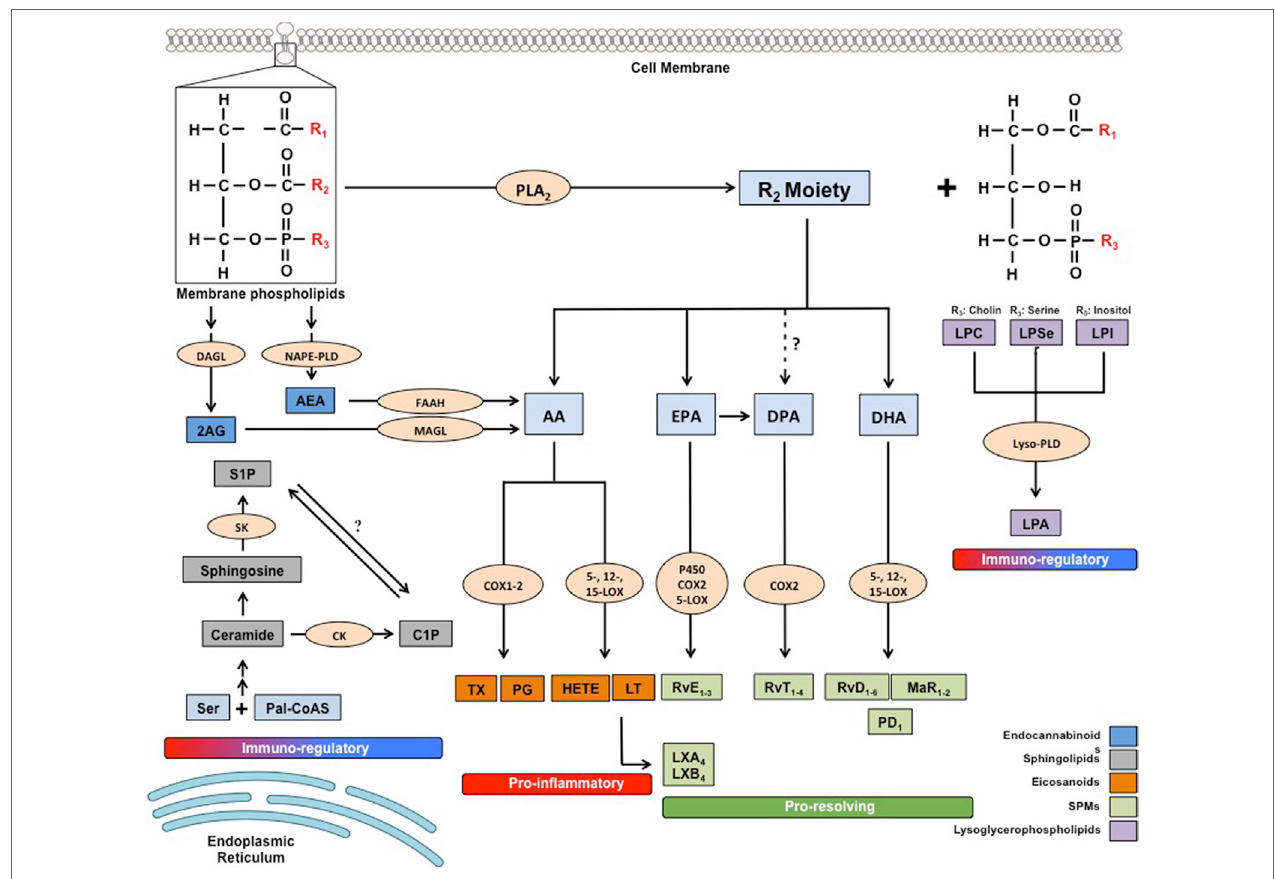
FigURe 1 | Metabolic pathways of the main families of endogenous bioactive lipids. 2-AG, 2 arachidonoylglycerol; AA, arachidonic acid; AEA, arachidonoylethanolamide; C1P, ceramide-1-phosphate; CK, ceramide kinase; COX, cyclooxygenase; DAGL, diacylglycerol lipase; DHA, docosahexaenoic acid; DPA, docosapentaenoic acid; EPA, eicosapentaenoic acid; FAAH, fatty acid amide hydrolase; HETEs, hydroxyeicosatetraenoic acids; LOX, lipoxygenase; LPA, lysophosphatidic acid; LPC, lysophosphatidilcholine; LPI, lysophosphatidylinositol; LPSer, lysophosphatidylserine; LTs, leukotrienes; LX, lipoxin; Lyso-PLD, lyso-phospholipase D; MAGL, monoacylglycerol lipase; MaR, maresin; NAPE-PLD, N -arachidonoylphosphatidylethanolamide-specific phospholipase D; Pal-CoASH, palmitoyl coenzyme A; PD, protectin; PDX, protectin DX; PGs, prostaglandins; PLA 2 , phospholipase A 2 ; Rv, resolvin; S1P, sphingosine-1-phosphate; SK, sphingosine kinase; TXs,